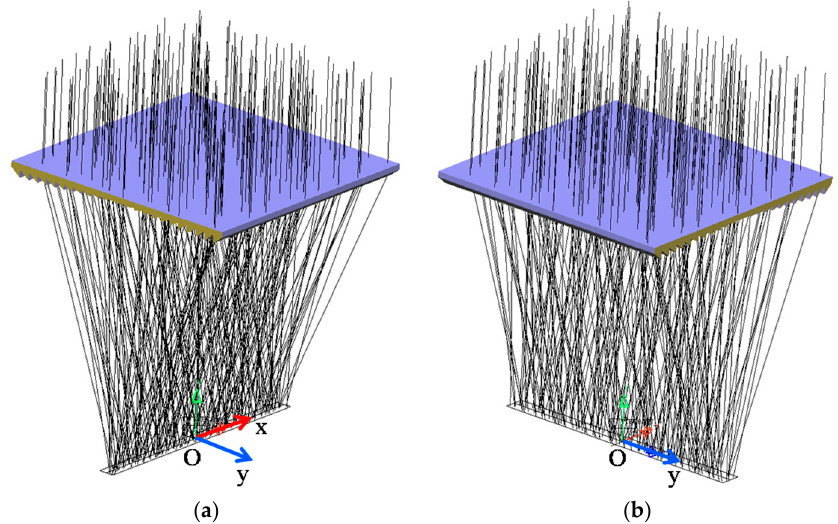
→ Oy . Figure 3. The linear Fresnel lenses with ( a ) the linear Fresnel lens focuses the sunlight on dimension (cid:1841)(cid:1876) (cid:4652)(cid:4652)(cid:4652)(cid:4652)(cid:1318) ;